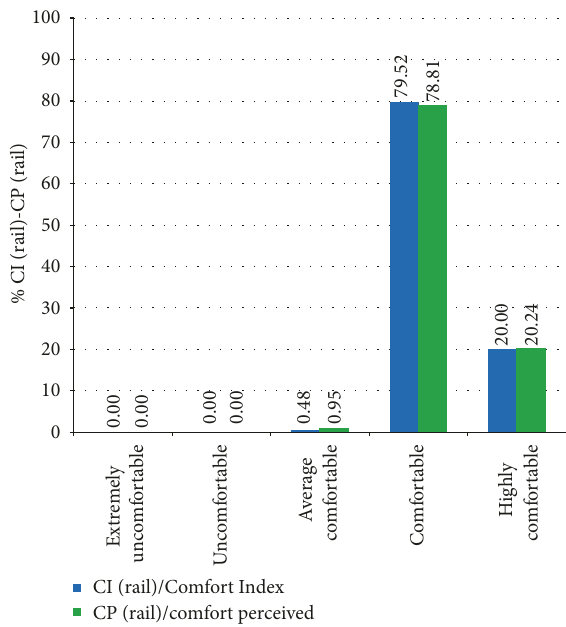
Figure 14: Comparison CI and CP-DE M4c.500 Stadler